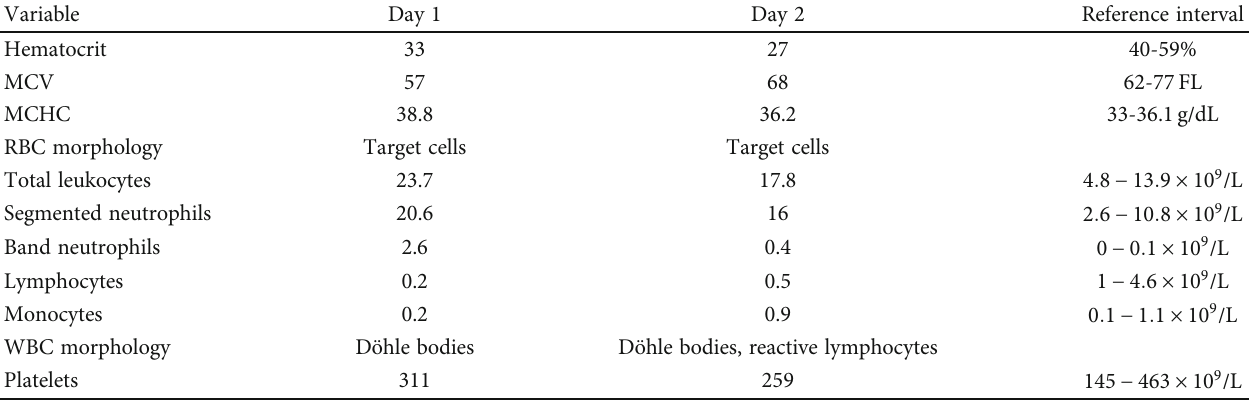
Table 1: Serial CBC results.